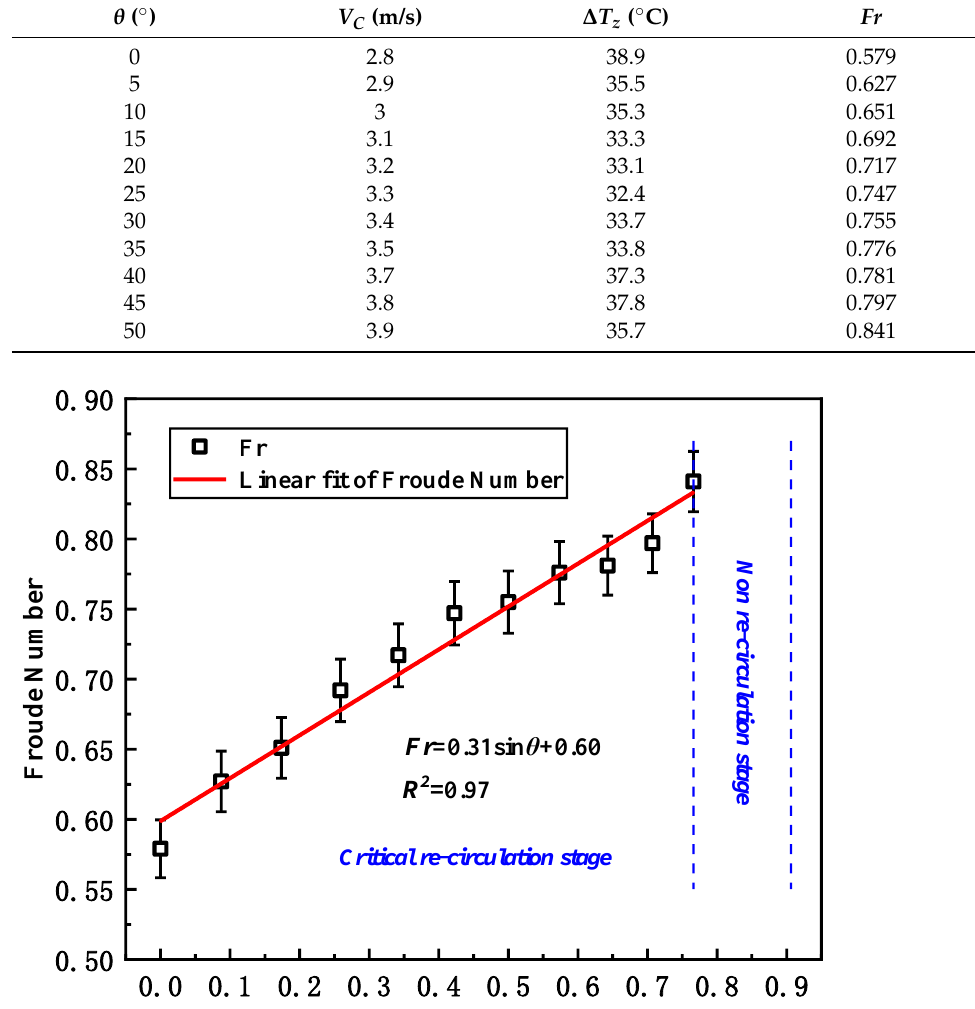
Table 2. The critical velocity and Froude number for different wind-direction conditions.